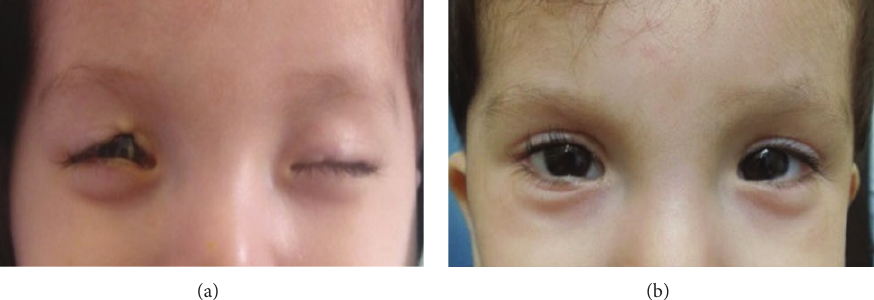
Figure 2: (a) Case 4 with 5 months old. The patient has bilateral eyelid coloboma. (b) Case 4. At the age of 2 years after surgery.